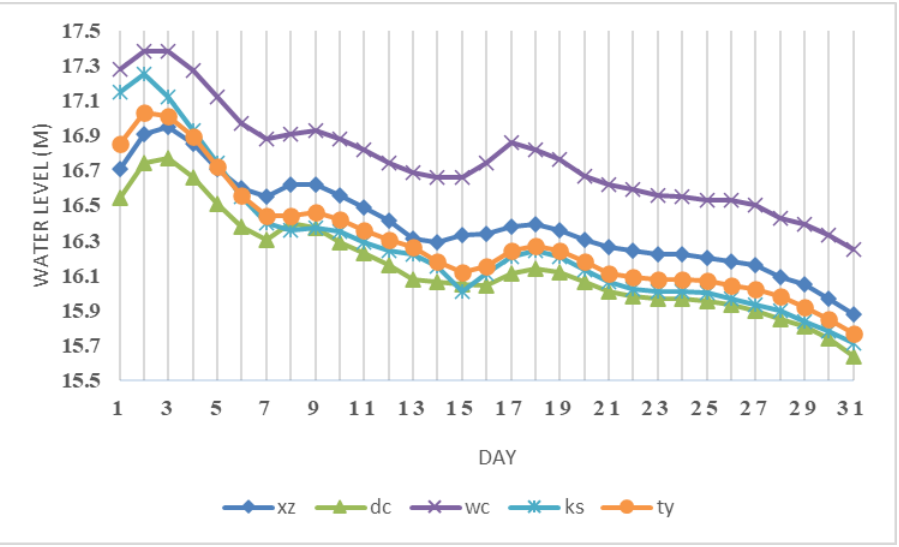
Figure 10. Daily Water Level of five Stations of Poyang Lake in July 2013.